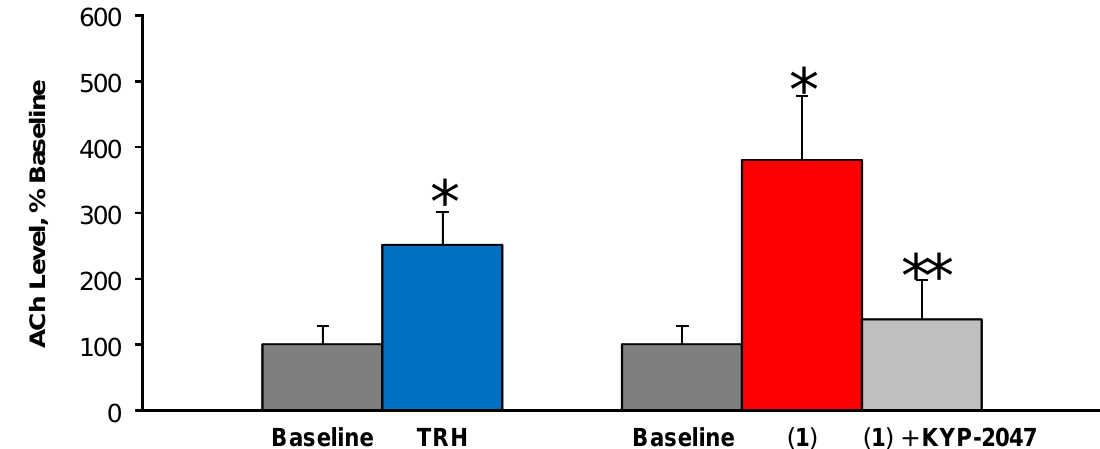
Figure 3. Percent acetylcholine (Ach) increase compared to steady-state baseline ACh concentration measured in samples collected before perfusion of the test agents taken as 100%. In the rat frontal cortex, prodrug ( 1 ) perfusion elicited an about 4-fold increase, while TRH as a positive control produced a 2.5-fold increase in ACh. * Indicates statistically significant difference ( p < 0.05) from baseline control. ** Indicates statistically significant difference ( p < 0.05) from prodrug perfusion, but no difference from the baseline.